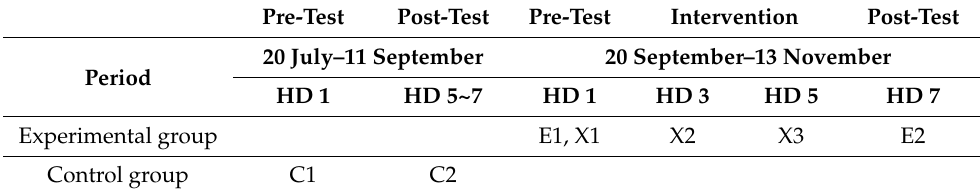
Table 2. Study design and